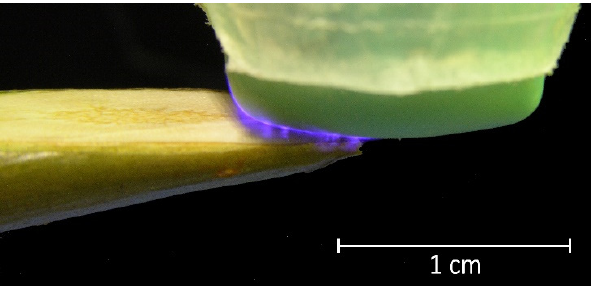
Figure 3. Photo of DBD CAP when processing a pear branch cut. The silicone cap of the output device contacts the surface and moves along the cut during treatment in a multi-pass approach.